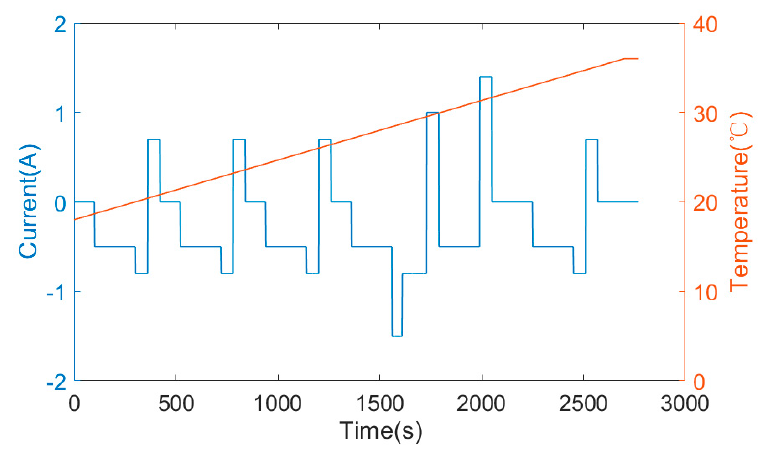
Figure 15. Improved DST profiles under variable temperature conditions.